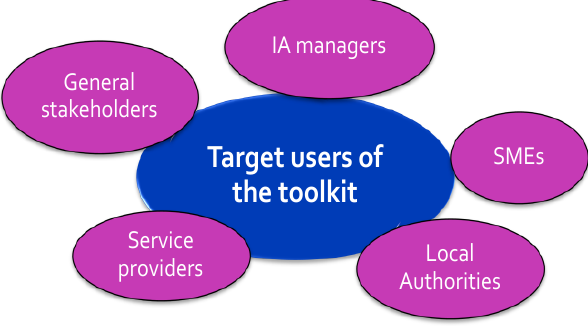
Figure 12. Users of the practice ―Sustainable Management of Industrial